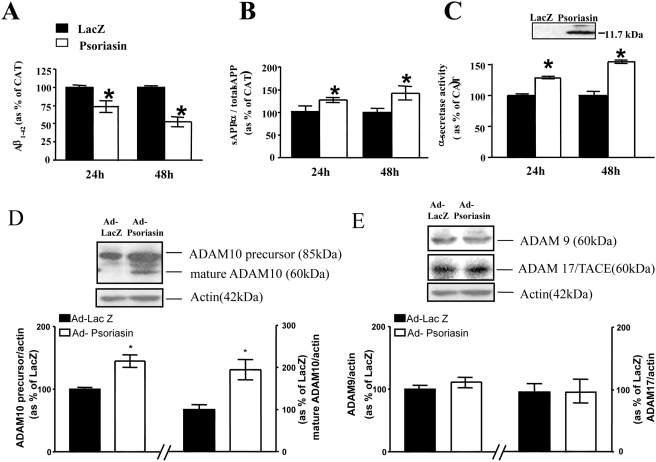
S100A7 expression attenuates β-amyloid peptide generation in cultured CHO-APPswe cells.Cells were infected with adeno human h-S100A7 virus or lacZ virus for 24 or 48 hours at 10 multiplicities of infection (MOI = 10). A, Amyloid-beta1–42 peptide content in the condition media was analyzed using a commercial ELISA assay. B, western blot analysis of soluble (s)APPα (6E10 antibody/total sAPP content (22C11 antibody) in the culture media. C, α-secretase activity of cell lysate assessed based on monitoring cleavage of a specific synthetic α-secretase peptide substrate using an α-secretase activity kit following manufacturer's instructions (R&D Systems). Inset, representative western blot analysis of h-S100A7 in culture media confirming the secretory feature of S100A7; Mature ADAM-10 (D) and mature ADAM-9 or ADAM-17 (TACE) (E) were assessed by western blot analysis. Insets, representative western blot analysis of precursor and mature ADAM-10 (D) and ADAM-9 or ADAM-17 (E). A–C, values represent mean±SEM and are shown as percent of LacZ control infected cells; n = 3 independent cultures per group from two independent studies; *P<0.05 by two-way t-test.